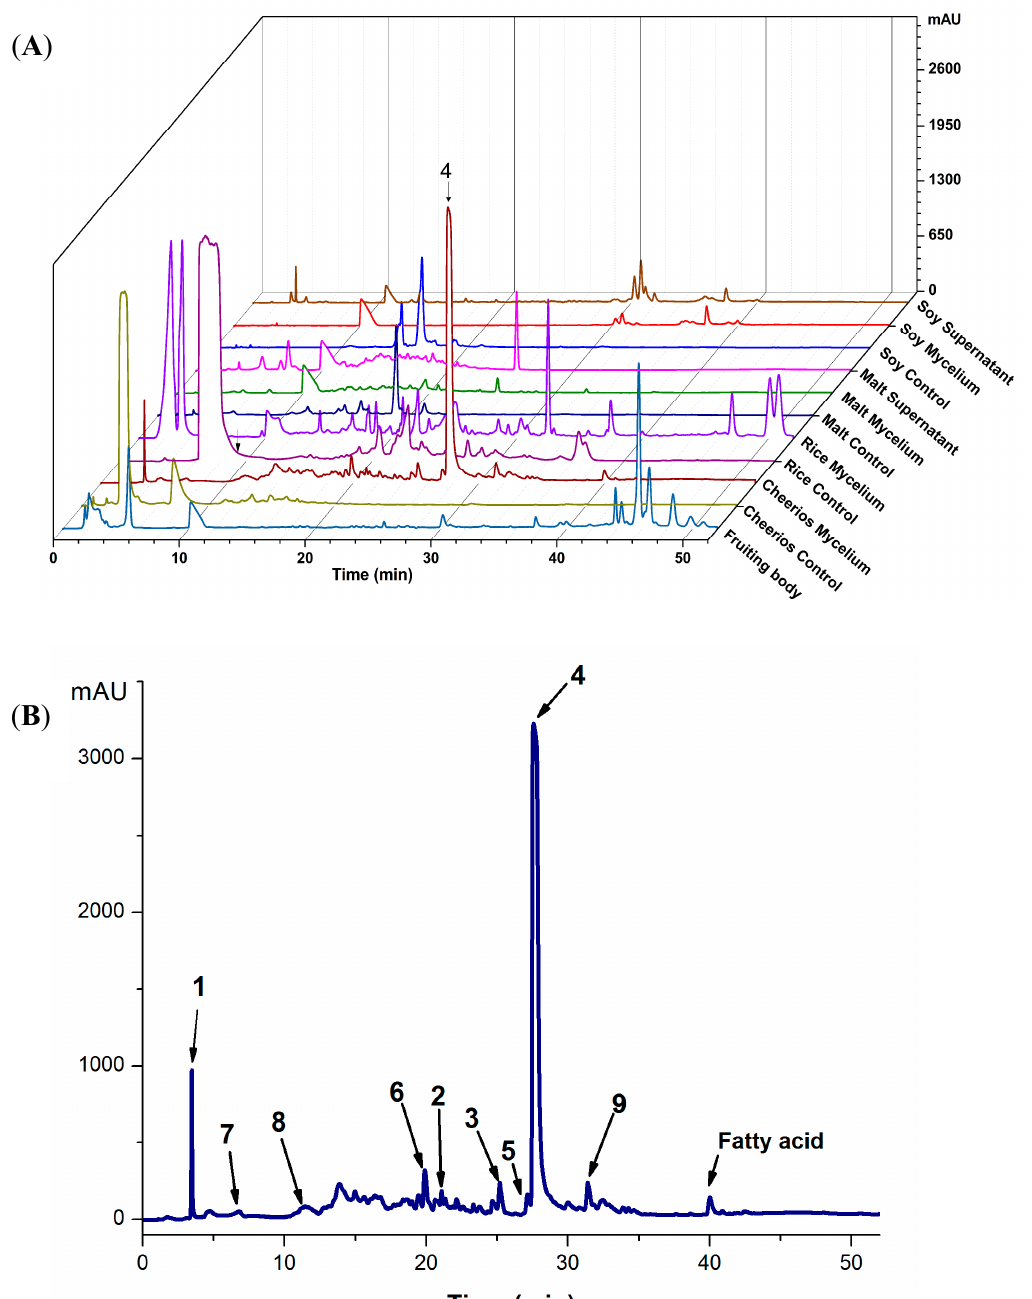
Figure 1. ( A ) Superimposed HPLC-DAD chromatograms at 220 nm of Hericium sp. WBSP8 extracts from a fruiting body and different cultures grown in liquid (soy, malt) or solid media (Cheerios, rice). The major peak corresponding to compound 4 (tR = 28 min) is indicated by an arrow. ( B ) HPLC chromatogram of the antifungal Cheerios extract recorded at 220 nm showing peaks corresponding to compounds 1 –